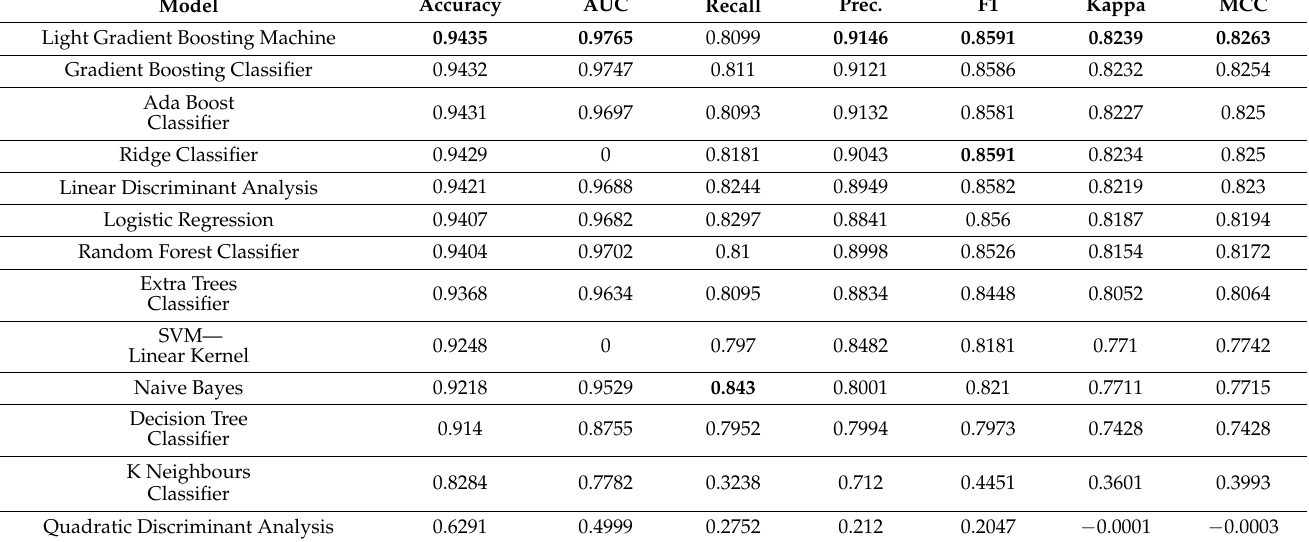
Table 3. Result of PyCaret ’s model comparison using 10 million randomly sampled rows of the 2021 training set. The best score per metric is marked in boldface. Accuracy: 94.35%, AUC: 0.9765, Precision 91.46%, F1: 0.8591, Kappa: 0.8239, MCC: